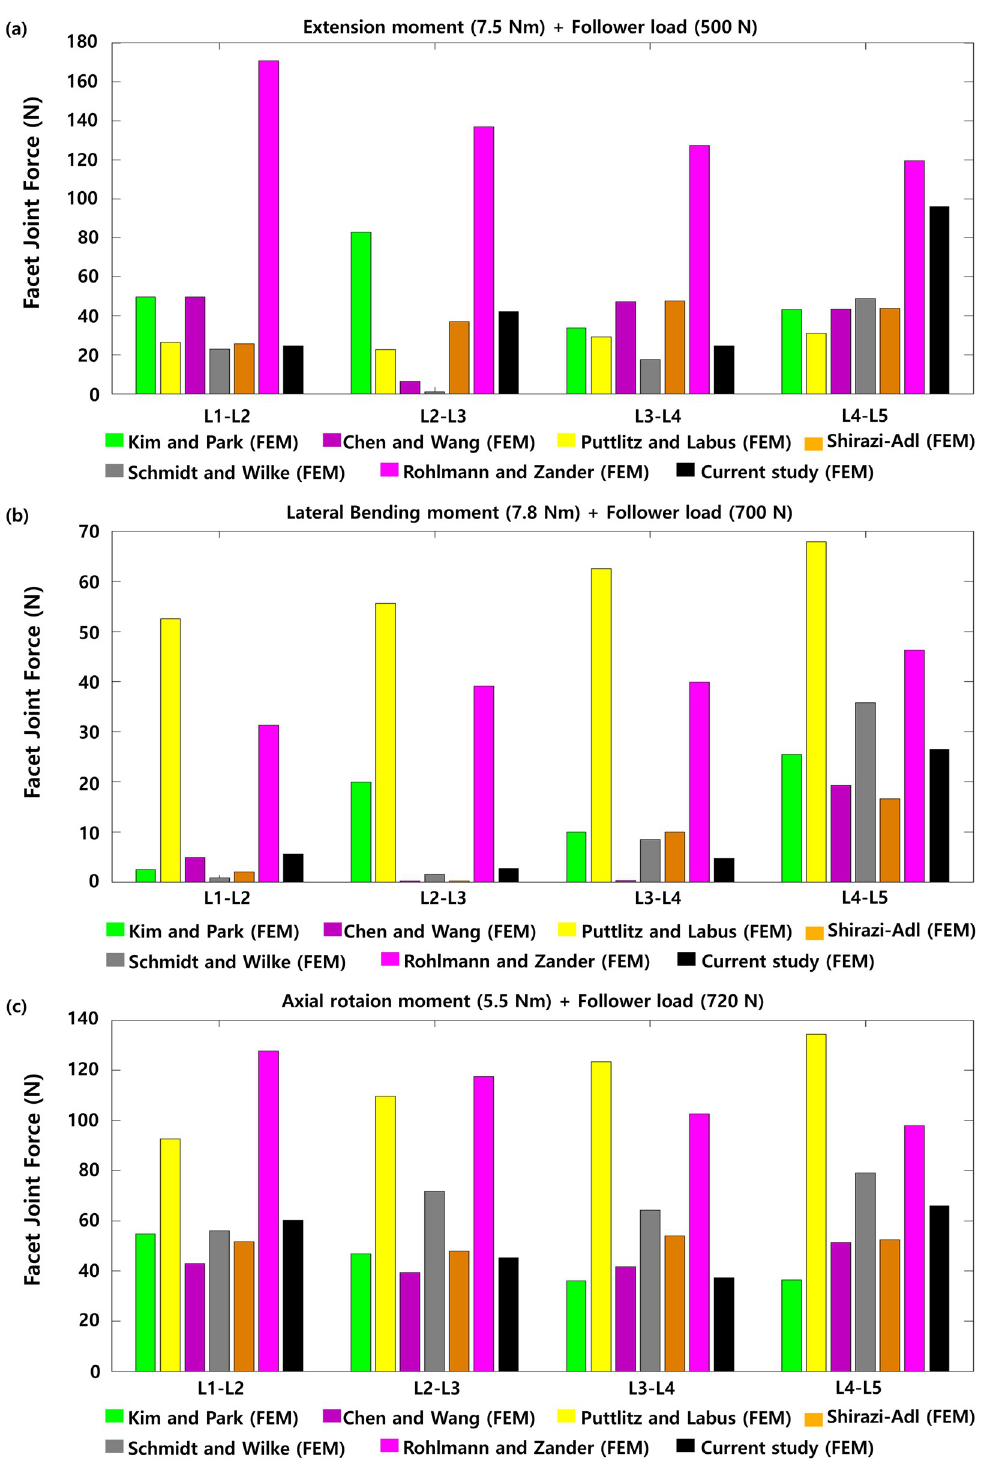
Fig 6. Facet joint force (FJF) of the two healthy lumbar spine joints under a combination of (a) flexion moment (7.5 N � m) and follower load (1175 N), (b) extension moment (7.5 N � m) and follower load (500 N), (c) lateral bending moment (7.8 N � m) and follower load (700 N), and (d) axial rotation moment (5.5 N � m) and follower load (720 N).